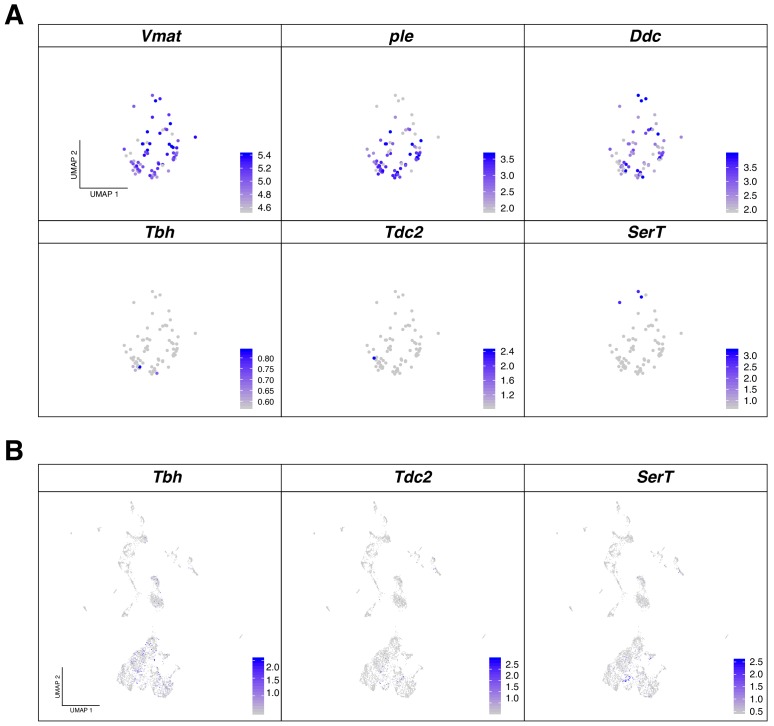
Monoaminergic neurons analysis.(A) Re-clustering analysis of monoaminergic neurons revealed an enrichment of Dopaminergic neurons. UMAP plot indicating the expression of dopaminergic marker genes: Vmat, ple and Ddc, against other aminergic markers: Tbh, Tdc2 and SerT. (B) The remaining aminergic neurons can be identified in different clusters in the original UMAP plot, validating the co-expression between neurotransmitters. Gene expression levels are color coded.